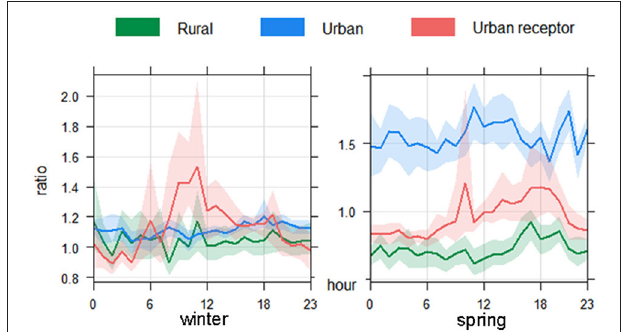
FIGURE 6 | Diurnal variation of the measured vs. predicted ammonium ratio. Mean (solid line) and 95% confidence intervals in the mean (darkened area around mean) indicated in plot.